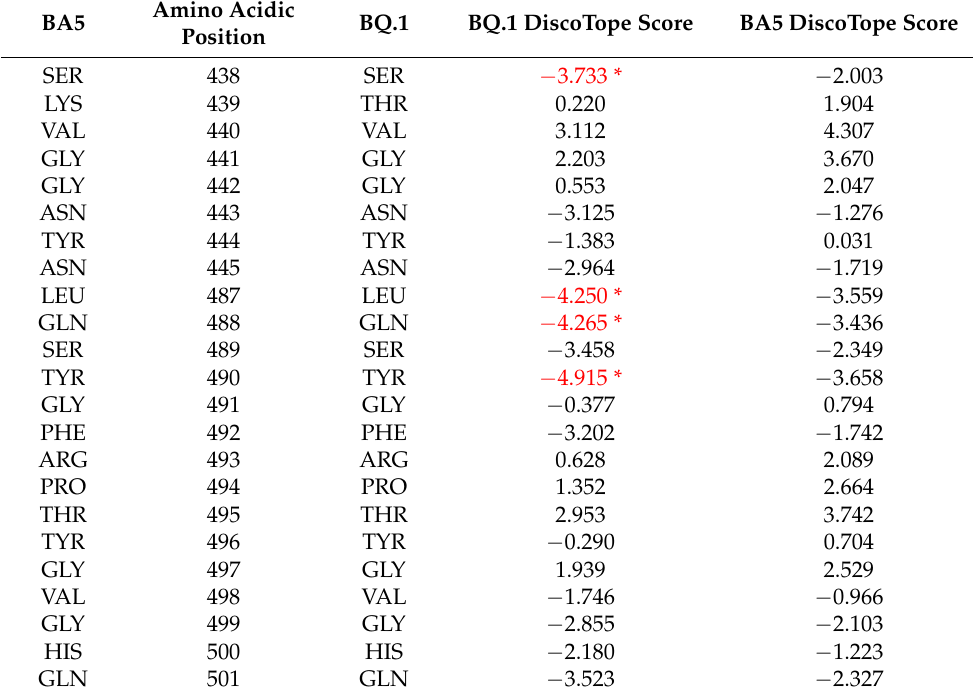
Table 3. The amino acidic position within the SARS-Cov-2 spike glycoprotein; the relative amino acids for BA.5 and BQ.1 are reported. DiscoTope scores for both variants are compared. Amino acids that have lost their potential to be considered probable B-cell epitopes are highlighted in red font and labeled with *. Amino Acidic BQ.1 BQ.1 DiscoTope BA5 Position